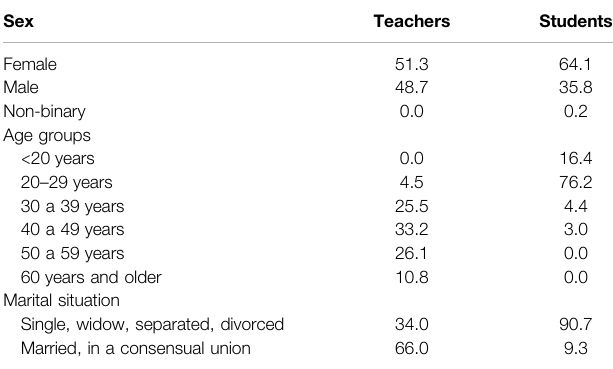
TABLE 1 | Demographic characteristics of